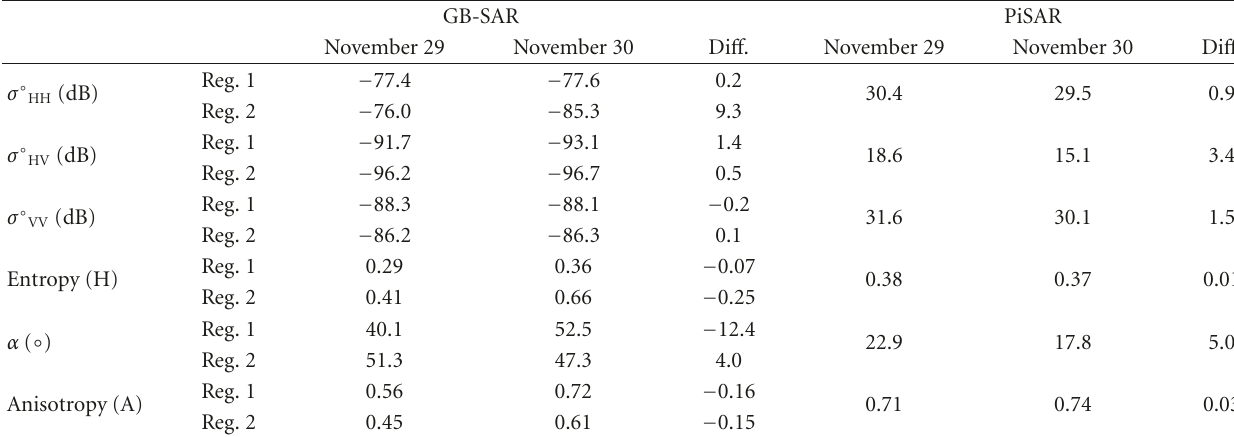
Table 3: Parameters derived from GB-SAR and PiSAR.